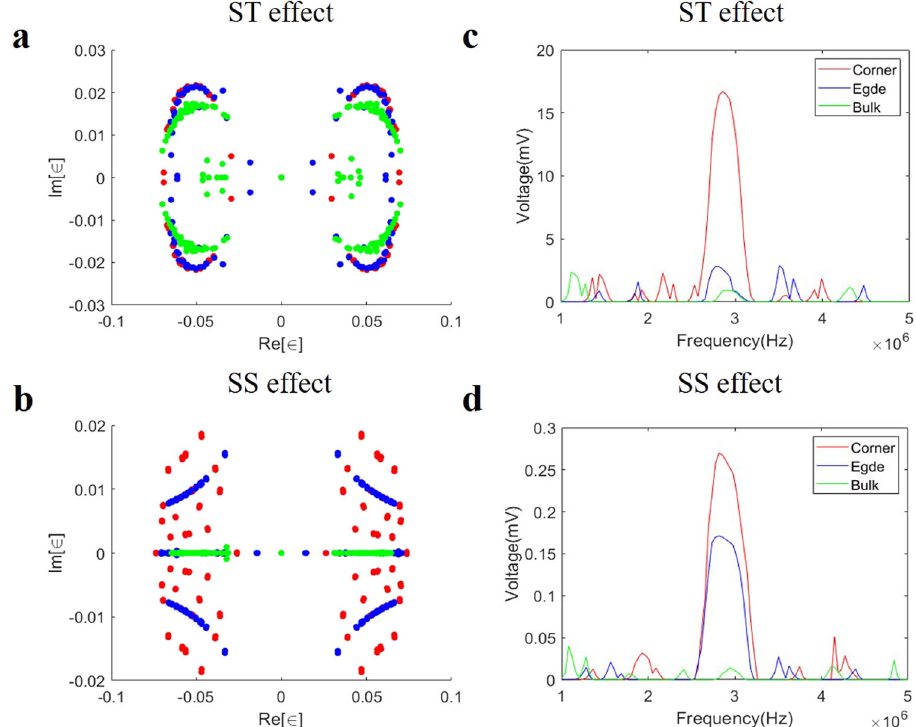
Fig. 4 The experimentally measured spectra and the voltage (corner, edge, and bulk) dependence on AC driving frequency for the hybrid second-order skin-topological (ST) and skin-skin (SS) effects. a , b The spectra of the fabricated electric circuit for the hybrid second-order ST effect ( a ) and SS effect ( b ). ∈ is eigenvalue. Red, blue and green dots represent the spectra subject to double periodic boundary conditions, x-periodic, y-open boundary conditions, and double open boundary conditions respectively. Comparison with Fig. 2 reveals very good agreement with theory. c , d The voltages (corner, edge, and bulk) with the frequency for the hybrid second-order ST and SS effects. Red, blue and green lines represent the voltages of sites at the corner, edge, and bulk, respectively, with the corner voltage peaking at the resonant frequency as expected from theory (Eq.